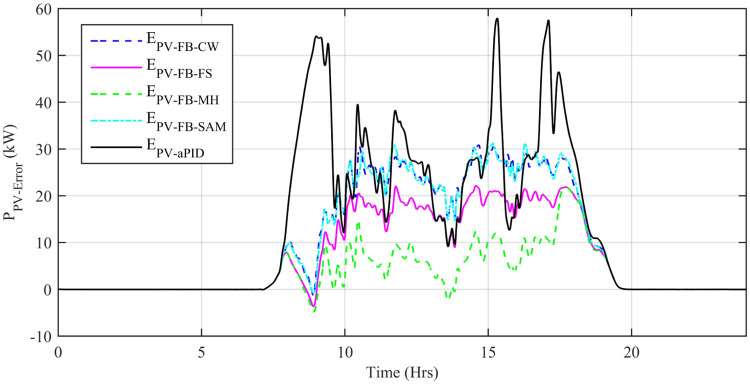
Power error in MPPT.